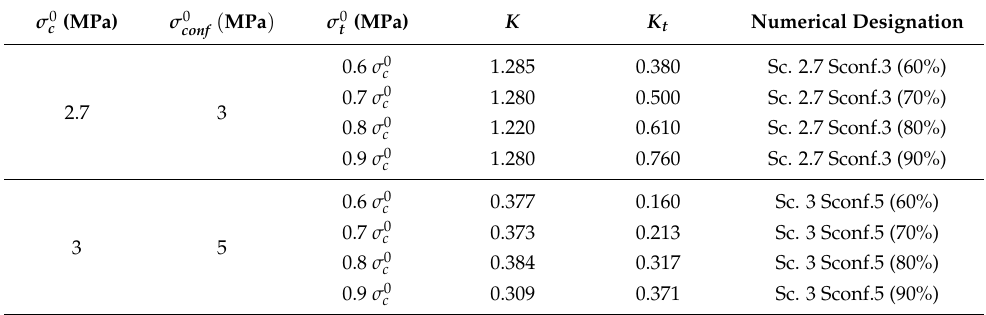
Table 2. Parameters of the CFV constitutive model obtained from numerical characterization of confined compression